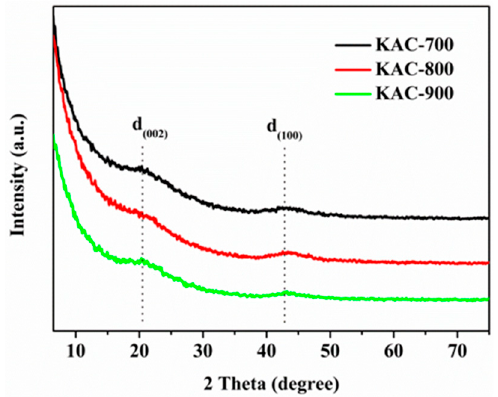
Figure 5. XRD patterns of samples.